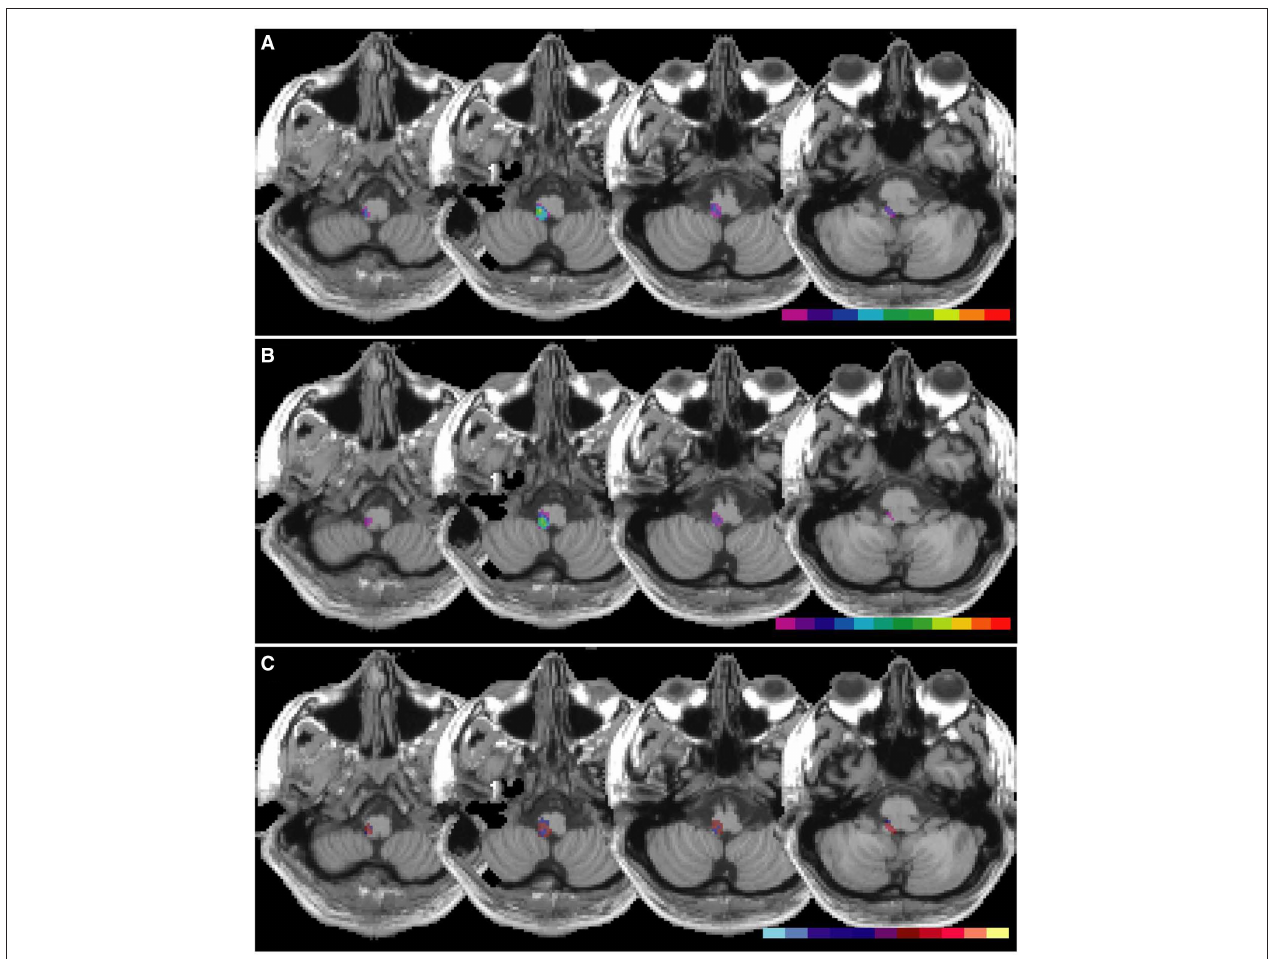
with normal cVEMP were subtracted from those of patients with abnormal cVEMP. The percentages of overlapping lesions after subtraction are indicated by five different color codings with increasing frequencies from dark red (difference 1–20%) to white–yellow (difference 80–100%). The colors from dark blue (difference − 1 to − 20%) to light blue (difference − 81 to − 100%) indicate the regions damaged more frequently in the patients with normal cVEMP than in those with abnormal cVEMP. Talairach z -coordinates of each transverse slice are